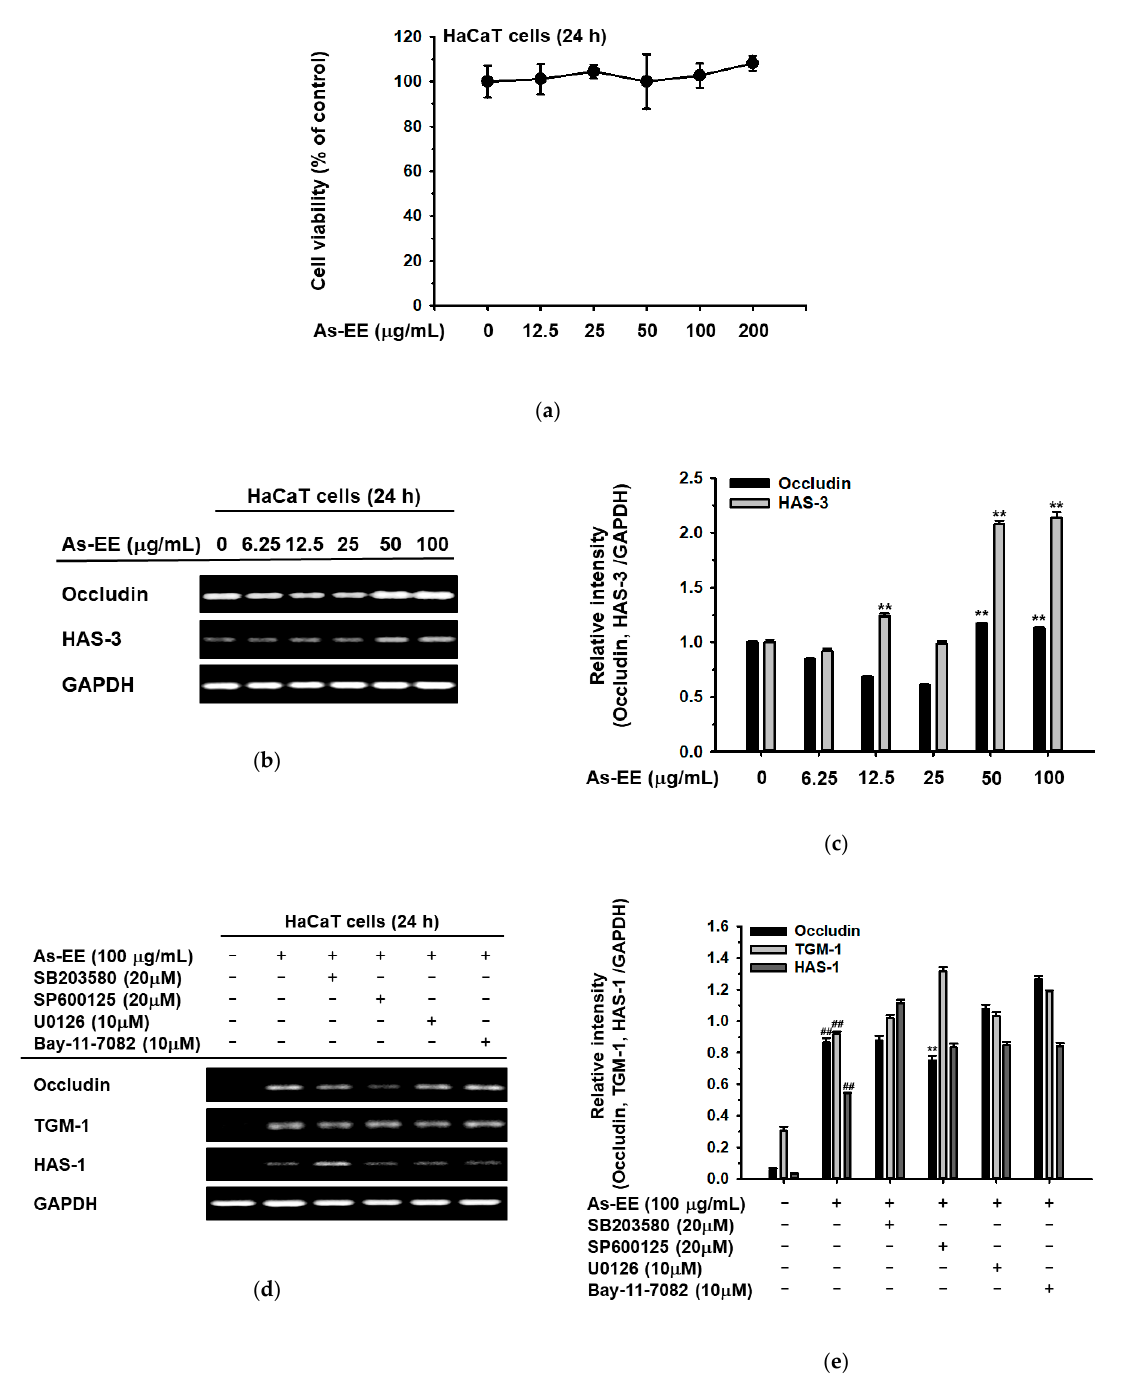
Figure 2. Effects of As-EE on cell viability and skin moisture-protection activity. ( a ) Cytotoxicity of As-EE was measured using a 3-(4-5-dimethylthiazol-2-yl)-2,5-diphenyltetrazolium bromide (MTT) assay in HaCaT cells; ( b ) The expression levels of skin-barrier-related and hydration factors were determined with RT-PCR in HaCaT cells after treatment with As-EE at doses ranging from 0 to 100 µ g/mL for 24 h; ( c ) The relative intensity of RT-PCR results (occludin and HAS-3) was measured with ImageJ; ( d ) Inhibitors were applied to HaCaT cells (SB20580, a p38 inhibitor; SP600125, a JNK inhibitor; U0126, an ERK inhibitor; and Bay117082, a κ B kinase inhibitor) for 24 h and the mRNA levels of occludin, TGM-1, and HAS-1 were measured with RT-PCR. ( e ) The relative intensity of mRNA levels was measured with ImageJ. # p < 0.05 and ## p < 0.01 compared with the normal groups. * p < 0.05 and ** p < 0.01 compared with the control